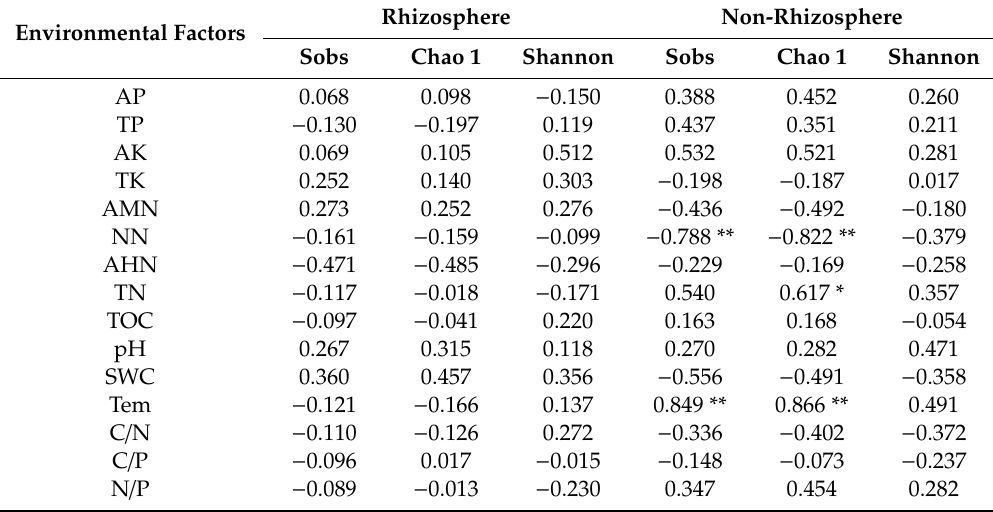
Table 2. Correlations between bacterial alpha-diversity and environmental factors based on Pearson correlation coe ffi cients with the two-tail